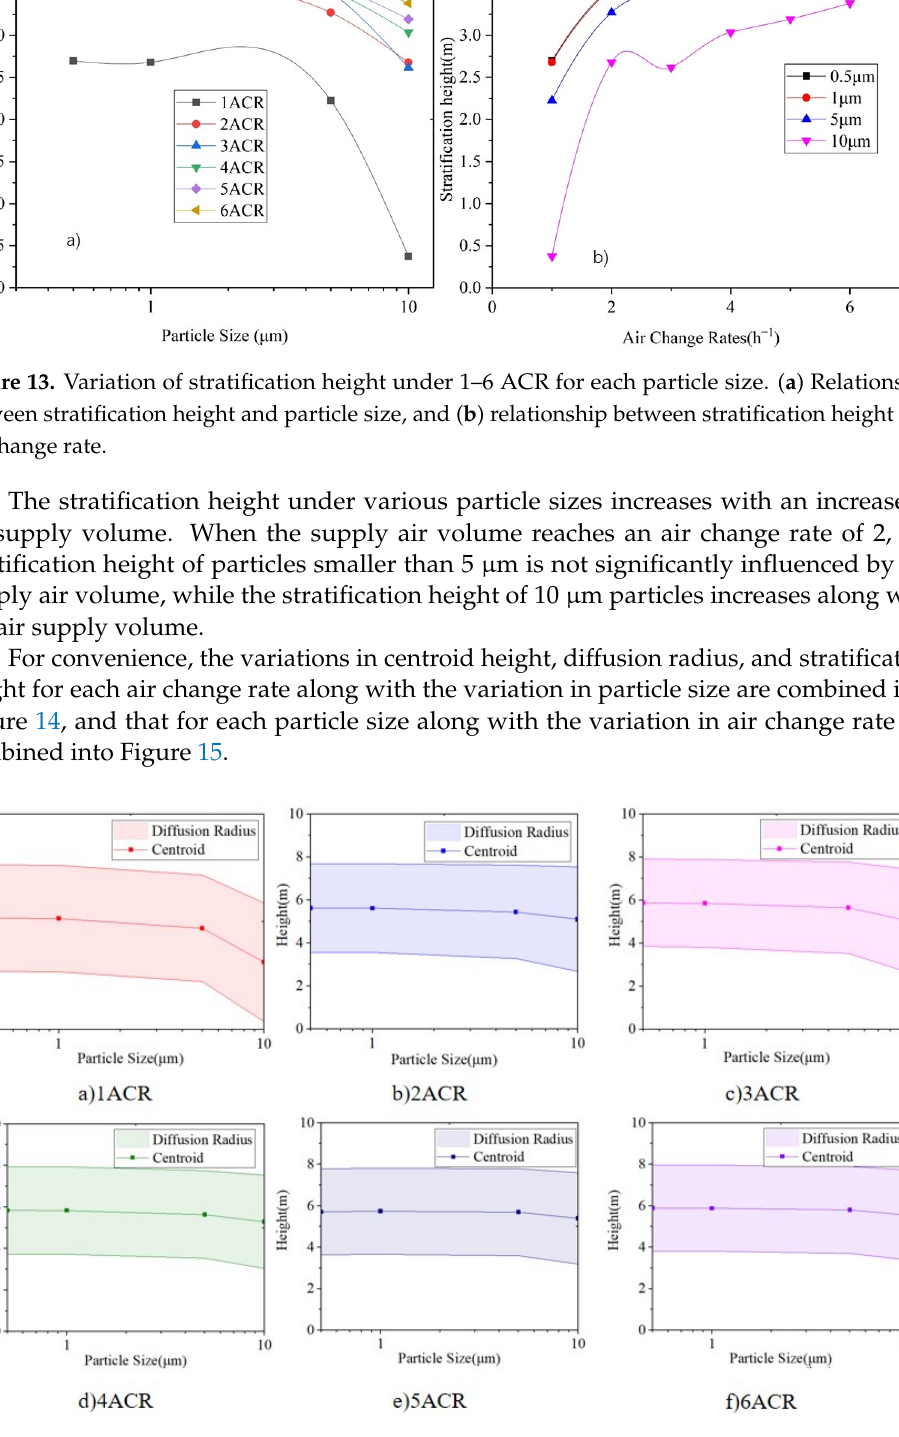
Figure 15. Relationship between centroid height, diffusion radius, and stratification height at each particle size with respect to the air change rate: ( a ) 0.5 μ m, ( b ) 1 μ m, ( c ) 5 μ m, and ( d ) 10 μ m. 3.4. Horizontal Plane Diffusion Radius The horizontal plane diffusion radius for each particle source was obtained by using Equation (13). Figure 16a shows a comparison of the inhomogeneity factor and horizontal plane diffusion radius under an ACR of 2. The curves in the red frame correspond to the